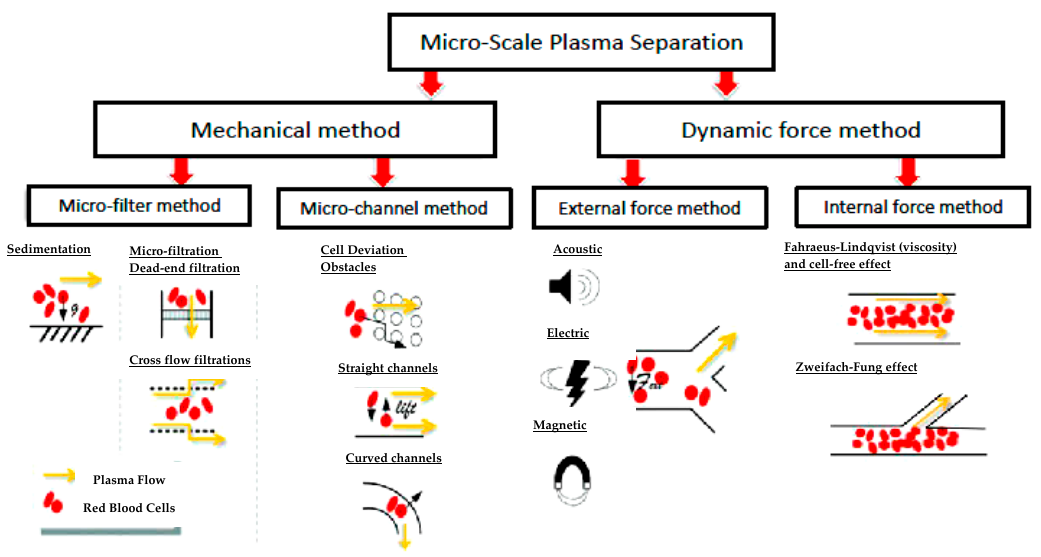
Figure 2 . Technological solutions for micro-scale plasma separation. The image is adapted and modified from Reference. [45]–Published by The Royal Society of Chemistry.